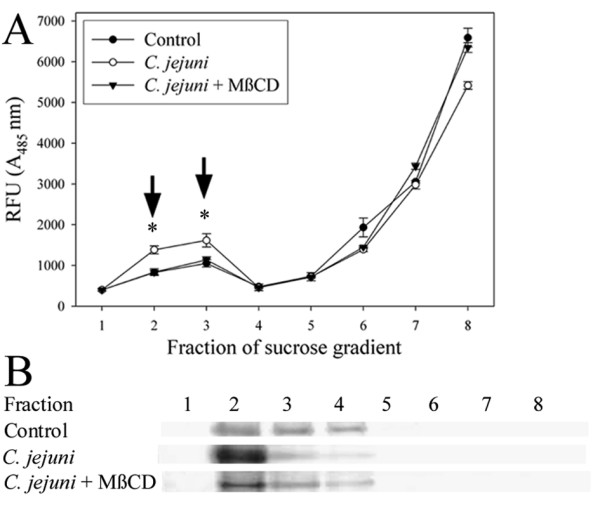
C. jejuni promotes association of E. coli with lipid rafts. (A) Lipid rafts were isolated by sucrose gradient fractionation and fluorescent E. coli in each fraction was measured (values are shown as relative fluorescence units (RFU)). Arrows indicate fractions containing lipid raft-associated E. coli. *P < 0.05 compared to control and cholesterol-depleted monolayers. Data are means ± SEM (n = 3). (B) Fractions were analyzed by western blot analysis for the lipid raft marker, caveolin-1. A representative image from three experiments is shown.